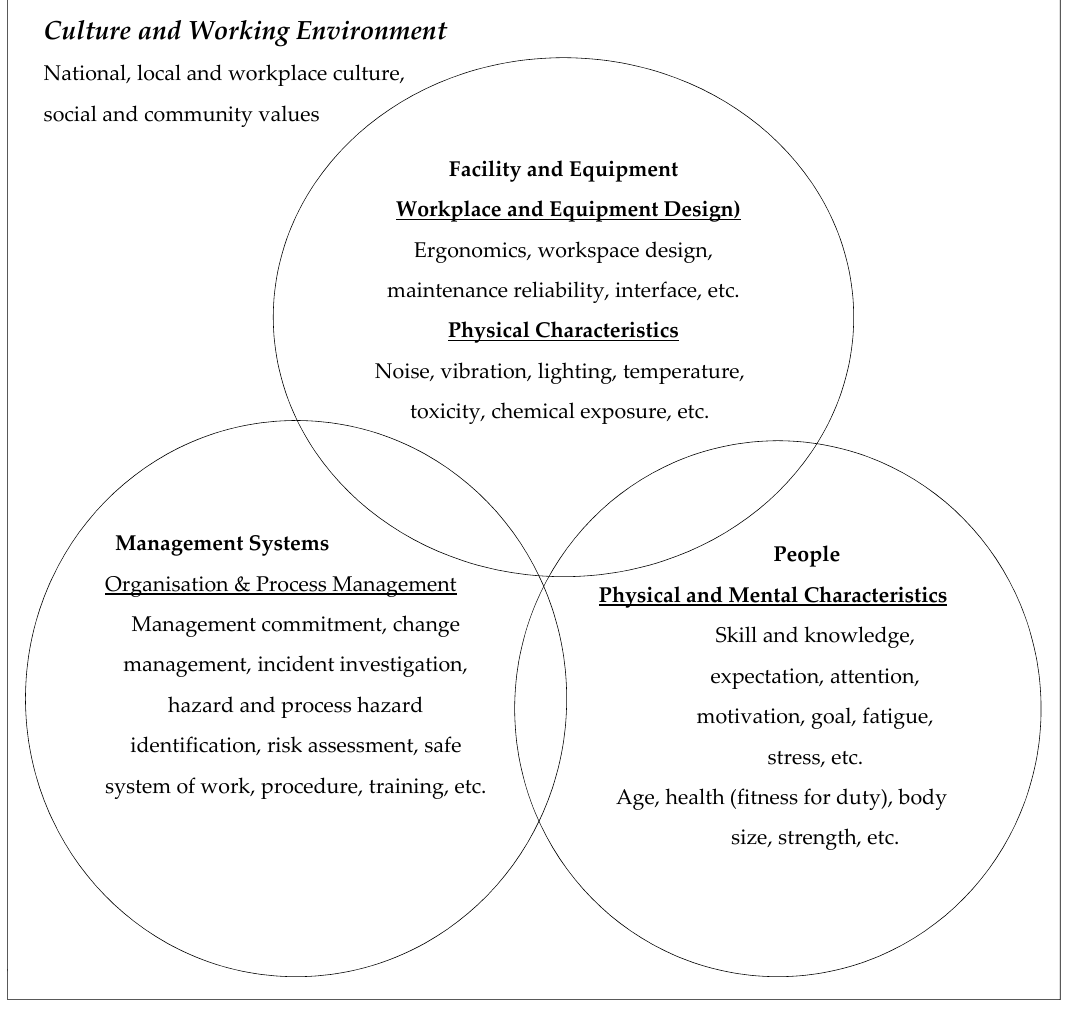
Figure 13. Complex interplay of human factors categories to undesired events (Adapted from IOGP [34]).